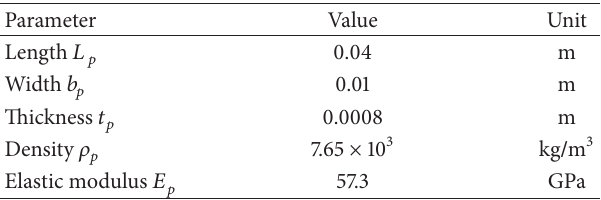
Figure 9. Then, the position of the piezoelectric actuator is set as input parameter, and the first-order natural frequency and second-order natural frequency are set as output